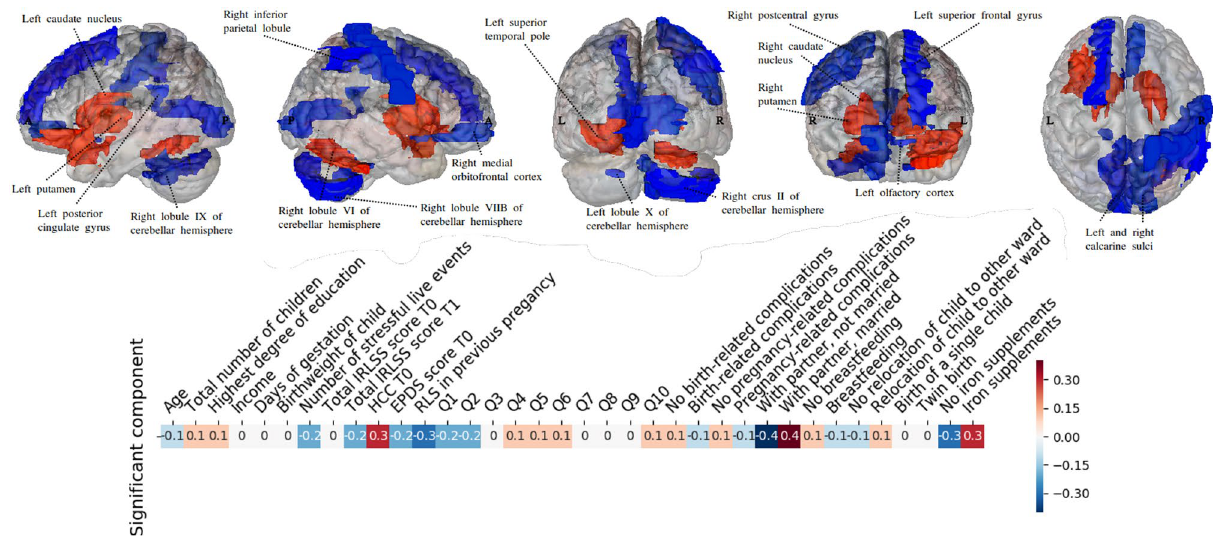
Figure 2. CCA reveals multivariate patterns of link between phenotypical predictors of RLS and brain structure. * IRLSS score T0 = Severity of RLS symptoms in pregnancy; IRLSS score T1 = Severity of RLS symptoms 12 weeks postpartum. The figure shows the first canonical model of brain-behavior co-variation that was statistically significant based on permutation testing ( p < 0.05). In the top row, the brain structure loadings are plotted from the left, right, posterior, anterior and superior views. The blue regions indicate the negative CCA loading associated with volume in this specific region, while the red region volumes indicate a positive CCA loading for this specific region. The bottom row depicts the loadings of the patient’s anamnestic and clinical indicators (blue for a negative loading and red for a positive one). A high hair cortisol level (HCC) during pregnancy, being married, and receiving iron supplement were robustly linked to an increased size of the left superior temporal pole, the left inferior frontal gyrus, the basal ganglia (right and left caudal nucleus and putamen), and the right lobule 6 of the cerebellar hemisphere. On the other hand, RLS during previous pregnancy (positive history of RLS), not being married and not receiving any iron supplement were found to